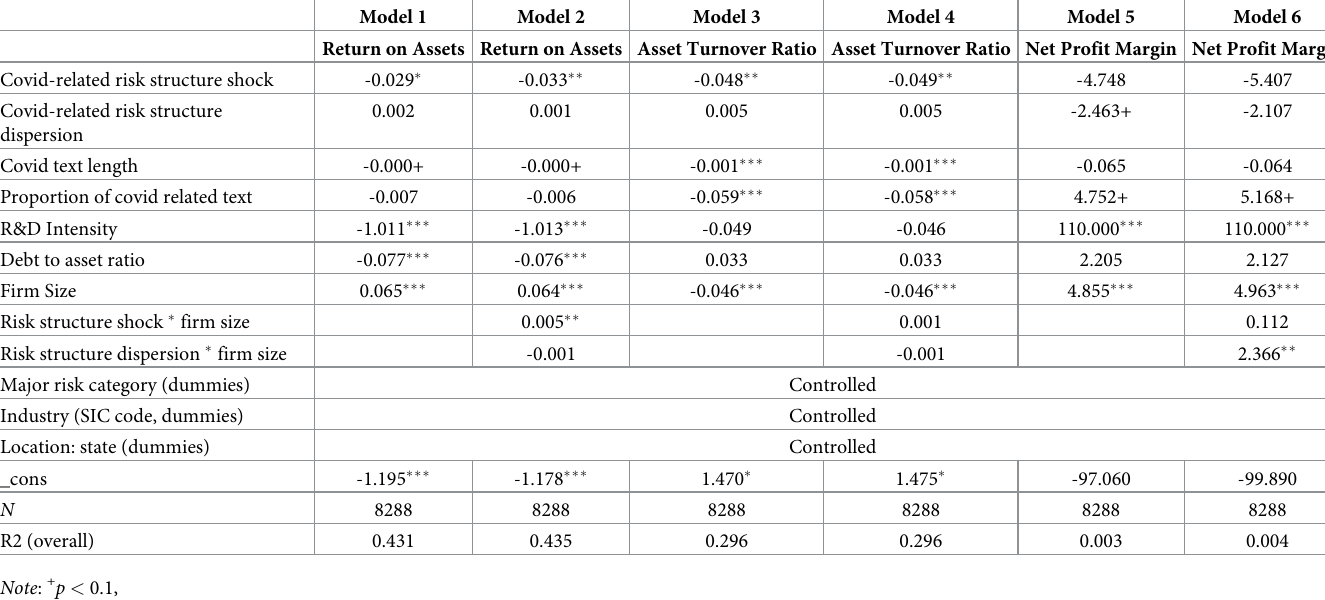
Table 2. Random effect model of covid-19 risk shock on company